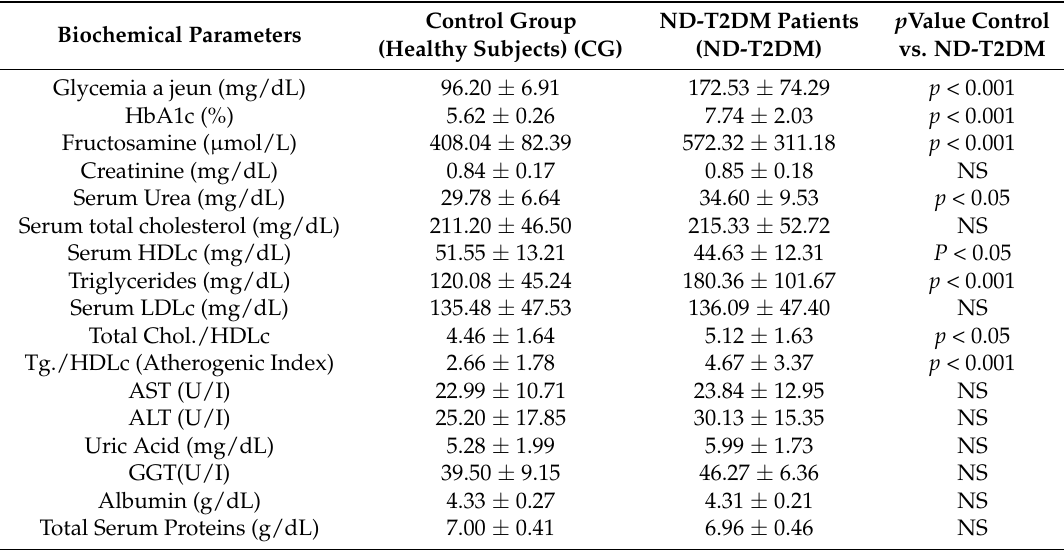
Table 2. The biochemical characteristics of T2DM patients versus healthy subjects.